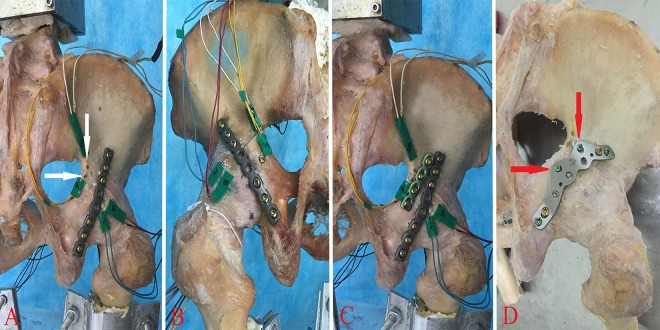
Groups of the different fixation constructs tested.(A) One 8-hole 3.5-mm reconstruction plate with six bicortical screws. (B) One 8-hole 3.5-mm reconstruction plate with six bicortical screws supplemented with one 4.5-mm posterior column lag screw. (C) One 8-hole 3.5-mm reconstruction plate with six bicortical screws and one 4-hole 3.5-mm reconstruction plate with four bicortical screws. (D) One 7-hole WAAP with two bicortical screws and four locking screws. White arrow, strain gauges; Red arrow, two locking screws in the medial column of the WAAP pointed towards the greater sciatic notch.